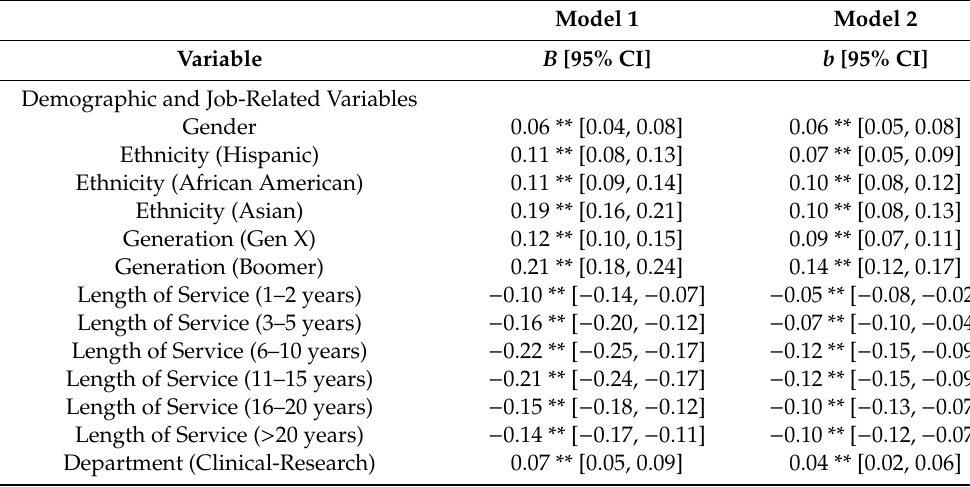
Table 5. Hierarchical multiple regression for demographic and attitude predictors of individual level